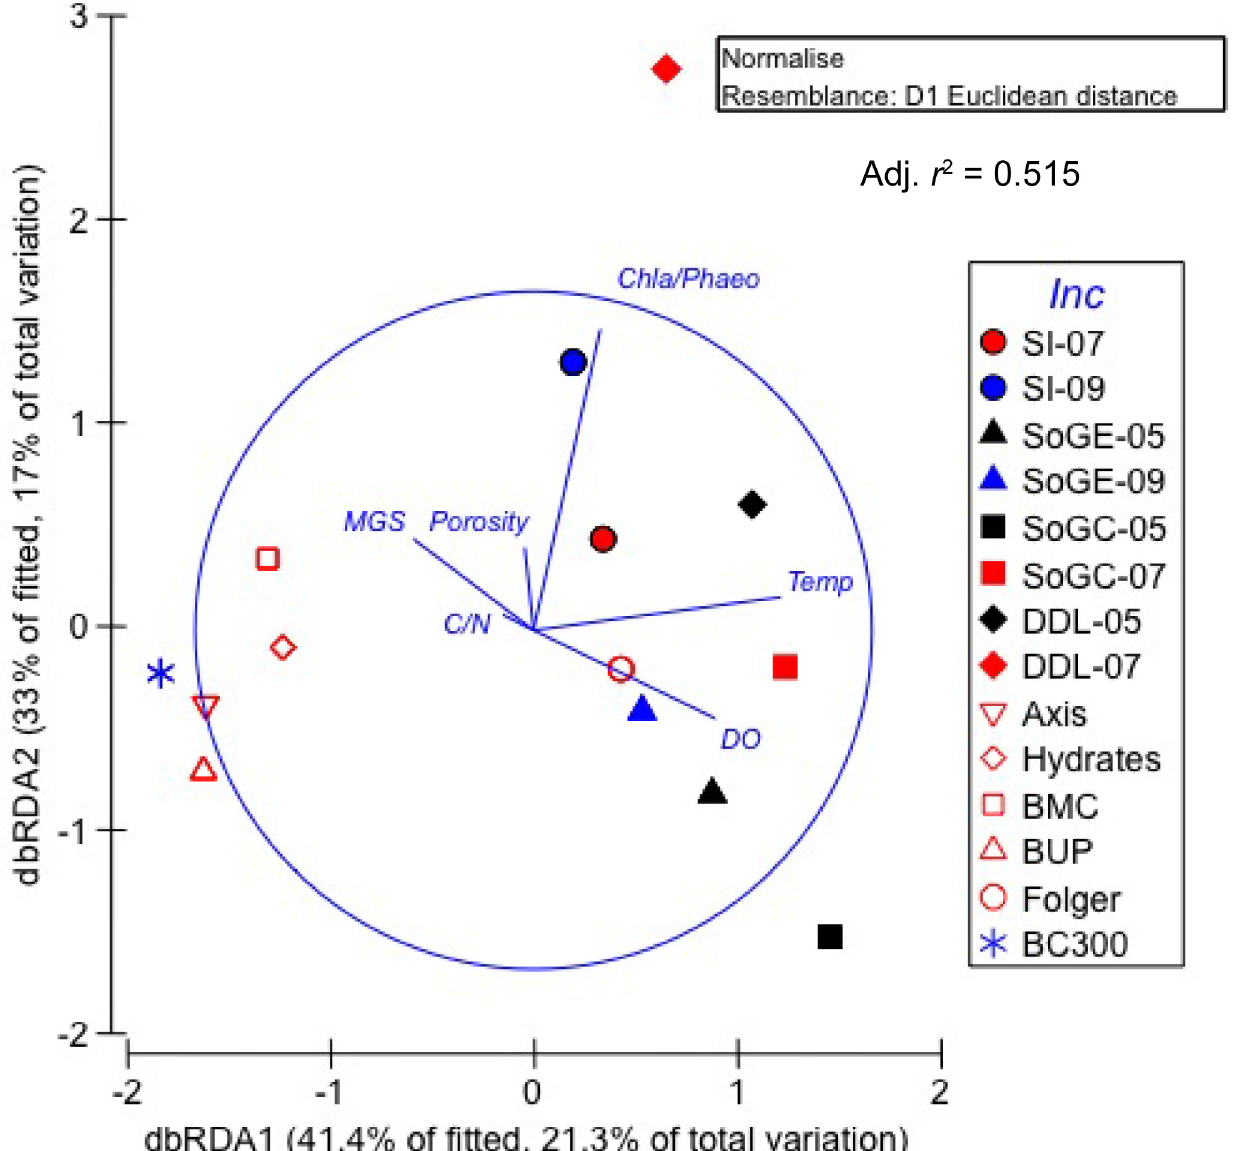
Fig 3. Distance-based Redundancy Analysis (dbRDA) plot of the distLM model of the predictor variables best explaining variation in benthic fluxes measured in the Salish Sea and NE Pacific in 2011 and 2013. Color represents sampling date: Black = May 2011; Red = July 2011; Blue = September 2013. Filled symbols denote benthic fluxes from the Salish Sea and open symbols denote NE Pacific benthic fluxes. Chl a :phaeo = Ln of sediment chl a :phaeo ratio; C:N = Ln of sediment carbon/nitrogen ratio; DO = bottom water dissolved oxygen concentration; MGS = sediment mean grain